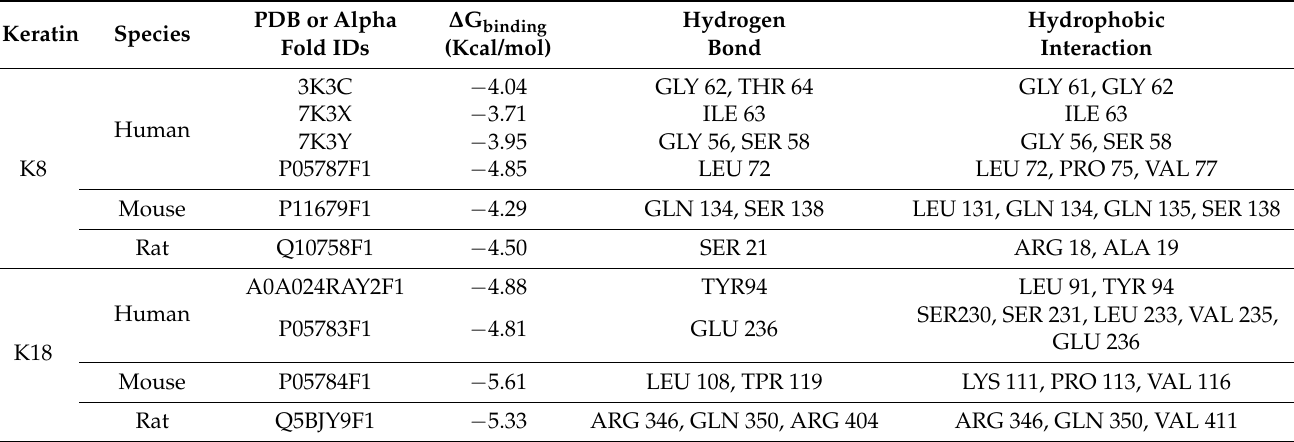
Table 4. Molecular docking details of 6-desmethylgriseofulvin (6-DMG) interaction with Keratin 8 (K8), and Keratin 18 (K18) in Human, Rat, and